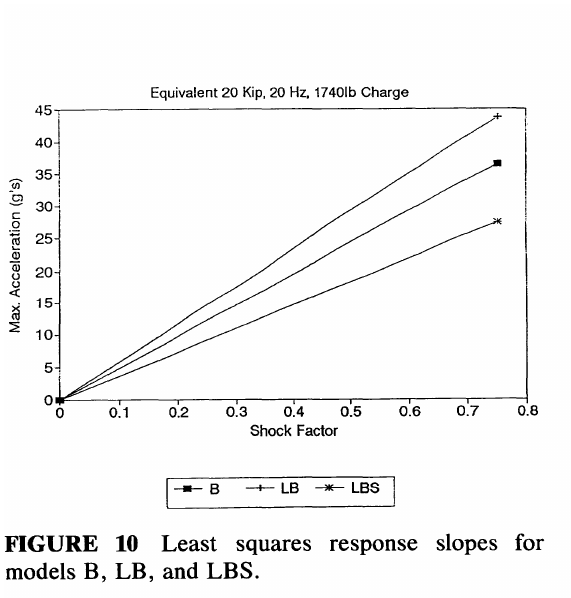
FIGURE 10 Least squares response slopes for models B, LB, and LBS.